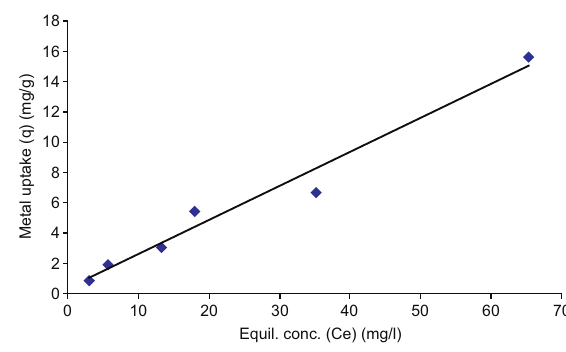
Figure 5 Adsorption isotherm for Zn.